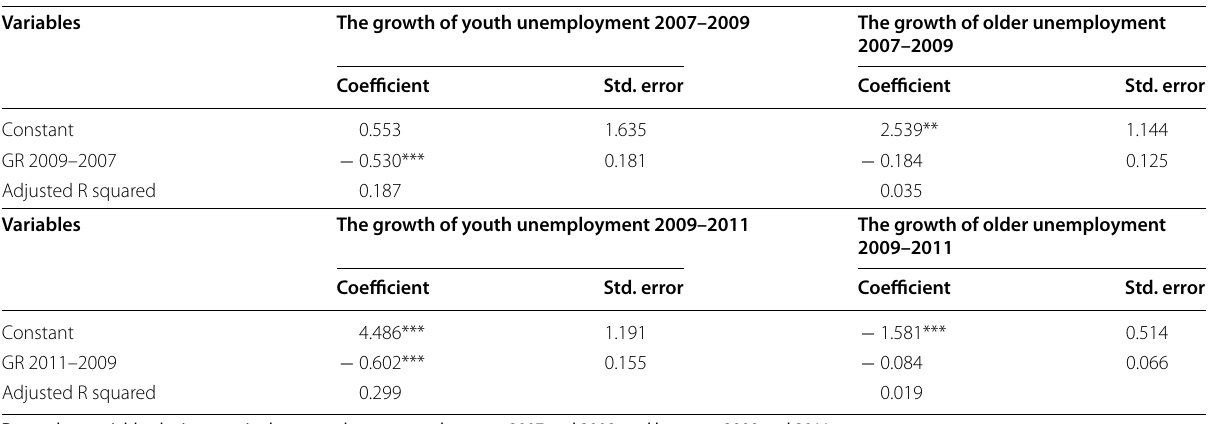
Dependent variable: the increase in the unemployment rate between 2007 and 2009, and between 2009 and